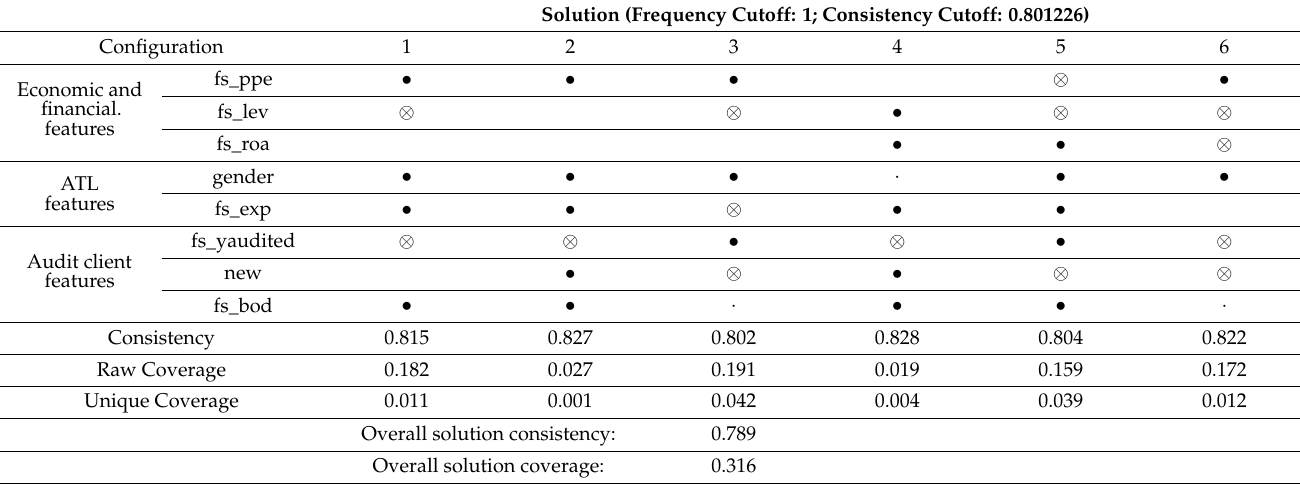
Table 8. Configurations sufficient for the presence of irregularities (Outcome: